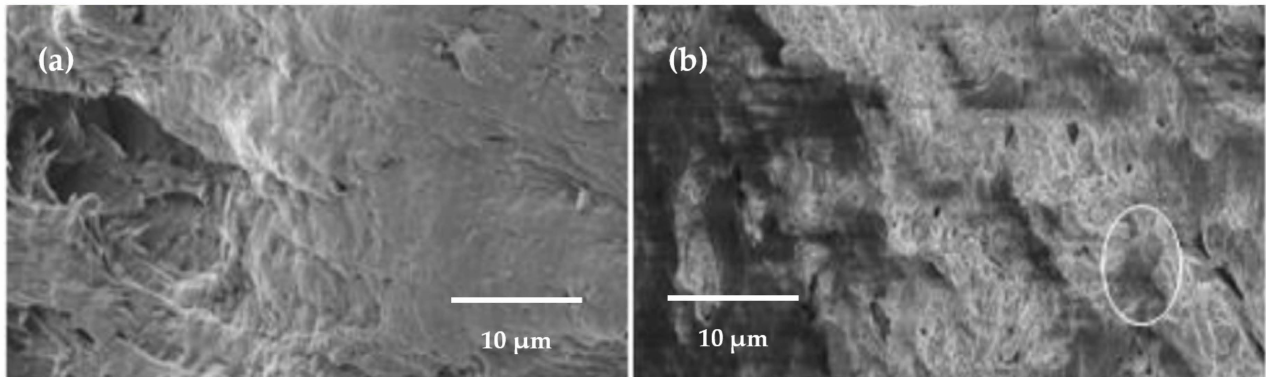
Figure 22. FE-SEM micrograph for TPS nanocomposite with 3 wt % of MMT ( a ) before degradation and ( b ) after degradation (60 days). Reproduced with permission from IOP Conf. Ser. Mater. Sci. Eng. , 410 , Behera, Mechanical and biodegradation analysis of thermoplastic starch reinforced nano-biocomposites, 2018